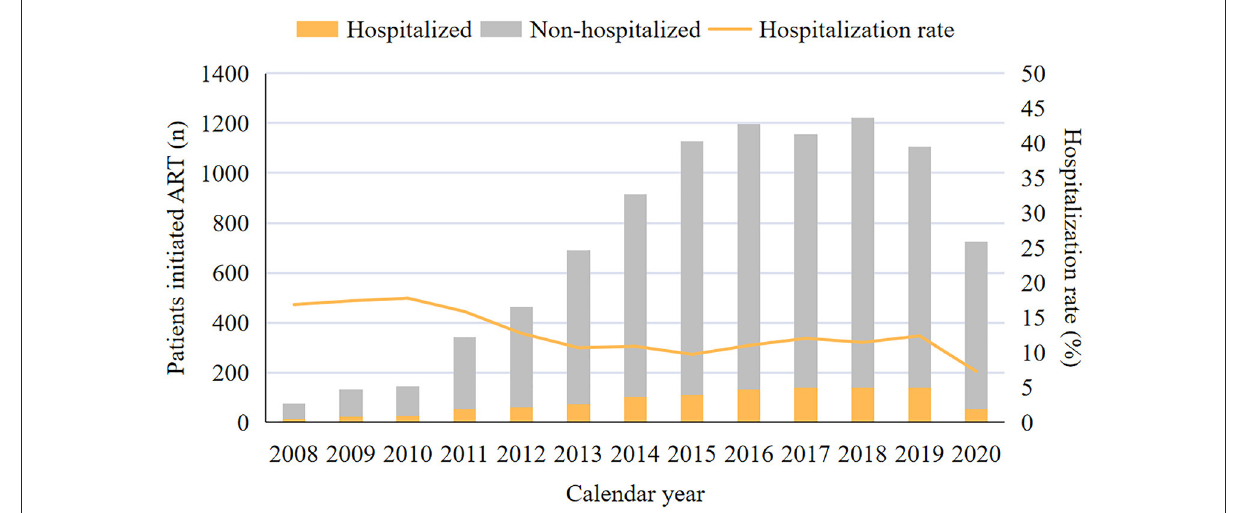
FIGURE5 Proportion of hospitalized patients at ART initiation, 2008–2020. ART, antiretroviral therapy.